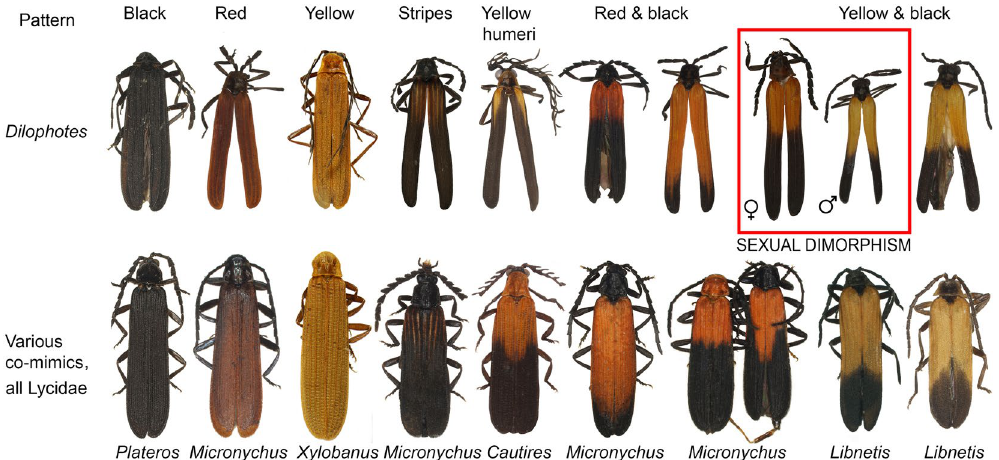
Figure 1. Aposematically coloured net-winged beetles. Photographs ©